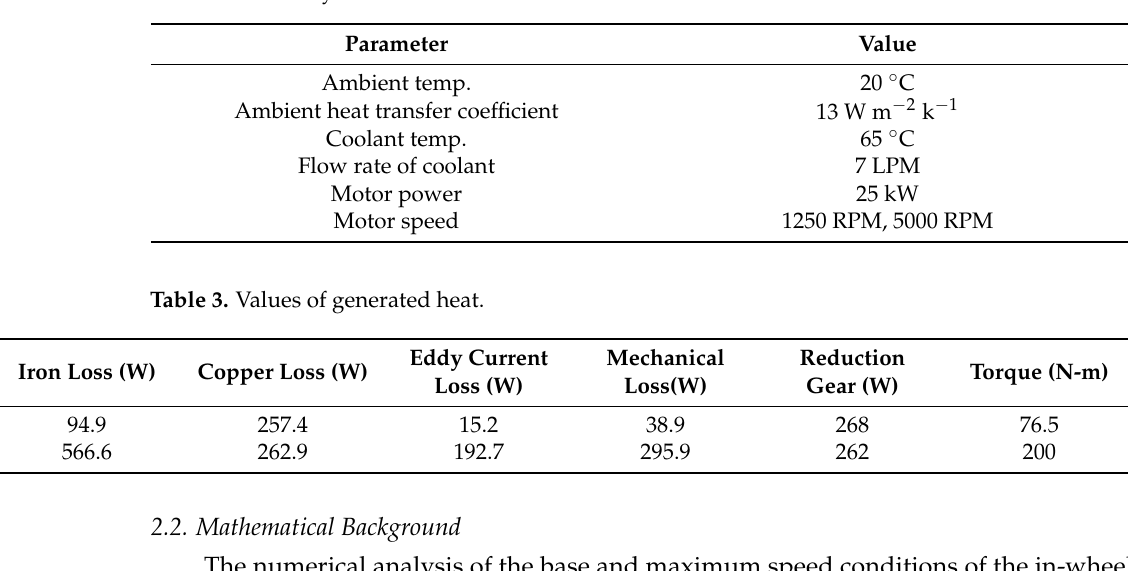
Table 2. Boundary conditions.